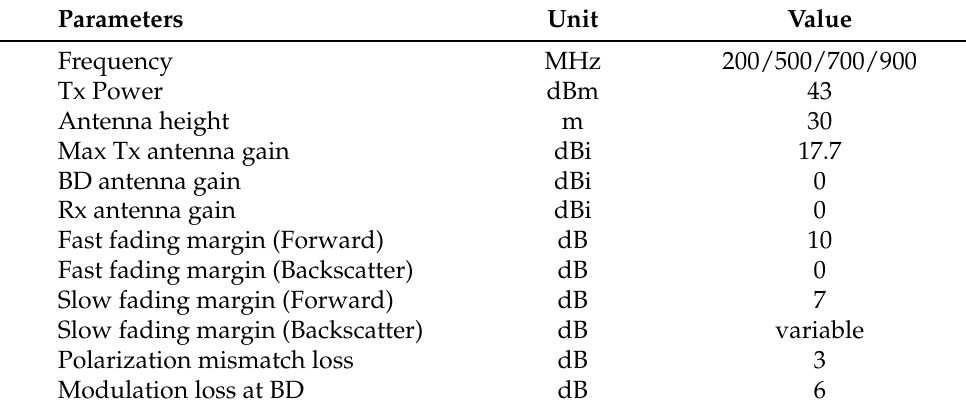
Table 3. General simulation parameters.